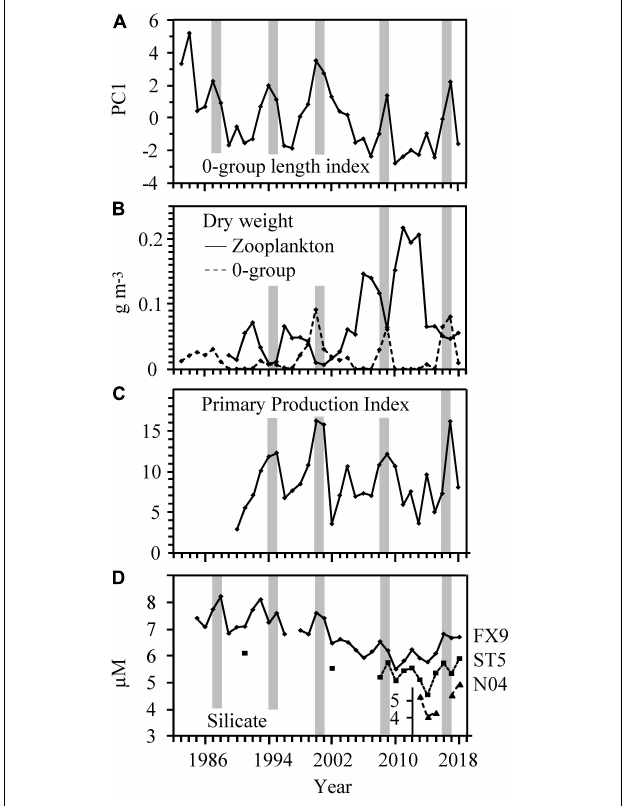
FIGURE 4 | Temporal development in the (A) 0-group length index (B) Zooplankton and 0-group biomass, (C) PPI from spring to late June, and (D) open-ocean pre-bloom silicate concentrations. The gray bars highlight periods of simultaneous high 0-group length index and biomass, low zooplankton biomass, high PPI and high silicate concentration.